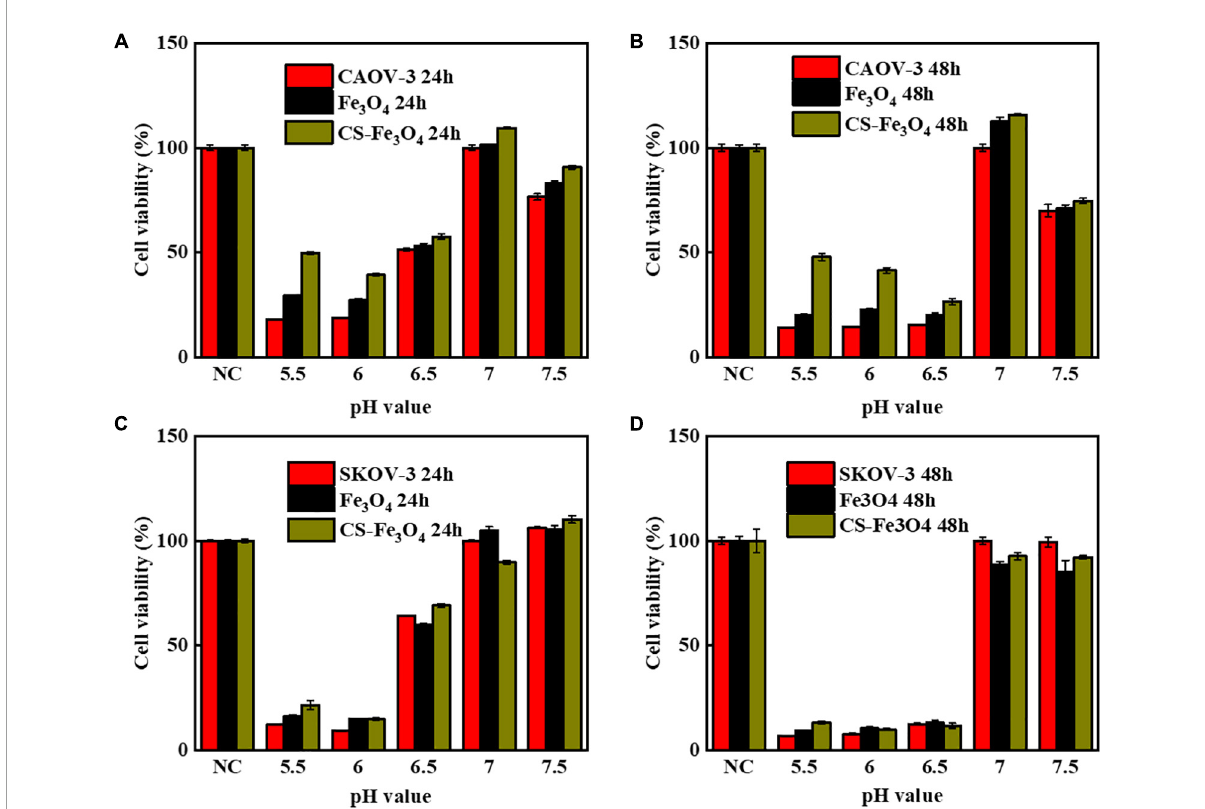
FIGURE6 Cell viability of (A) CAOV-3 cells treated for 24 h, Fe3O4 treated for 24 h, and CS-Fe3O4 treated for 24 h; (B) CAOV-3 cells treated for 48 h, Fe3O4 treated for 48 h, and CS-Fe3O4 treated for 48 h; (C) SKOV-3 cells treated for 24 h, Fe3O4 treated for 24 h, and CS-Fe3O4 treated for 24 h; (D) SKOV-3 cells treated for 48 h, Fe3O4 treated for 48 h, and CS-Fe3O4 treated for 48 h at different pH